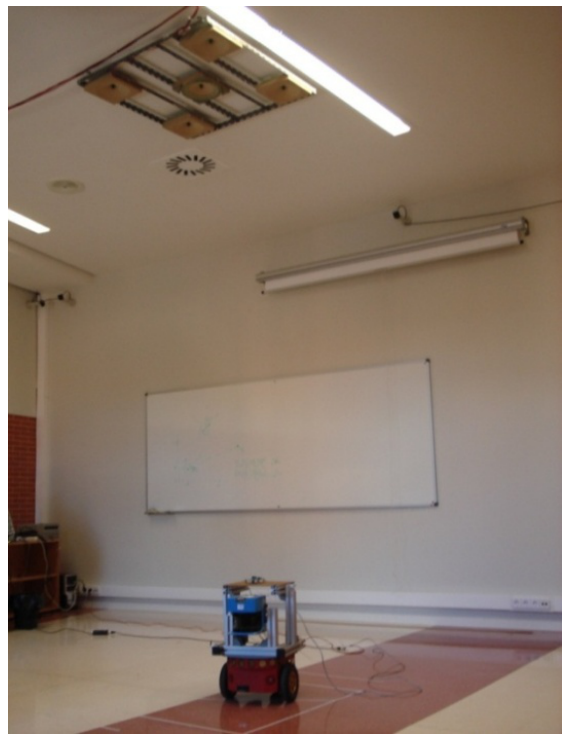
Figure 8. Ultrasonic LPS by GEINTRA used in experimental